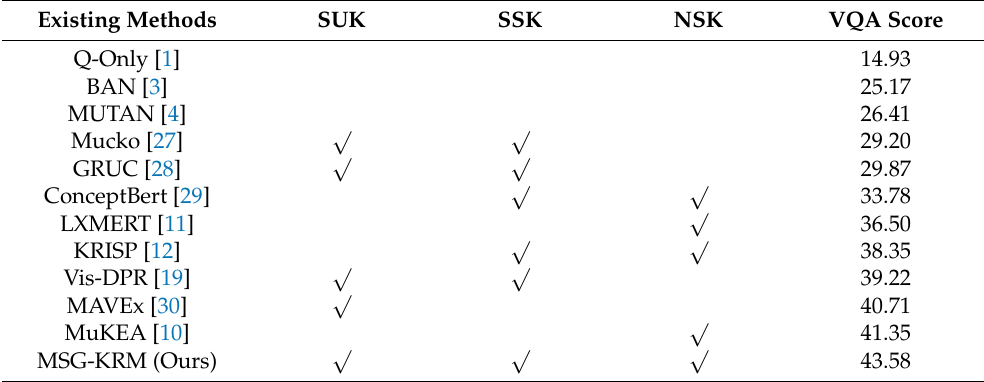
Table 3. Performance comparison on the OK-VQA dataset. SUK, SSK, and NSK represent symbolic unstructured knowledge, symbolic structured knowledge, and non-symbolic knowledge,